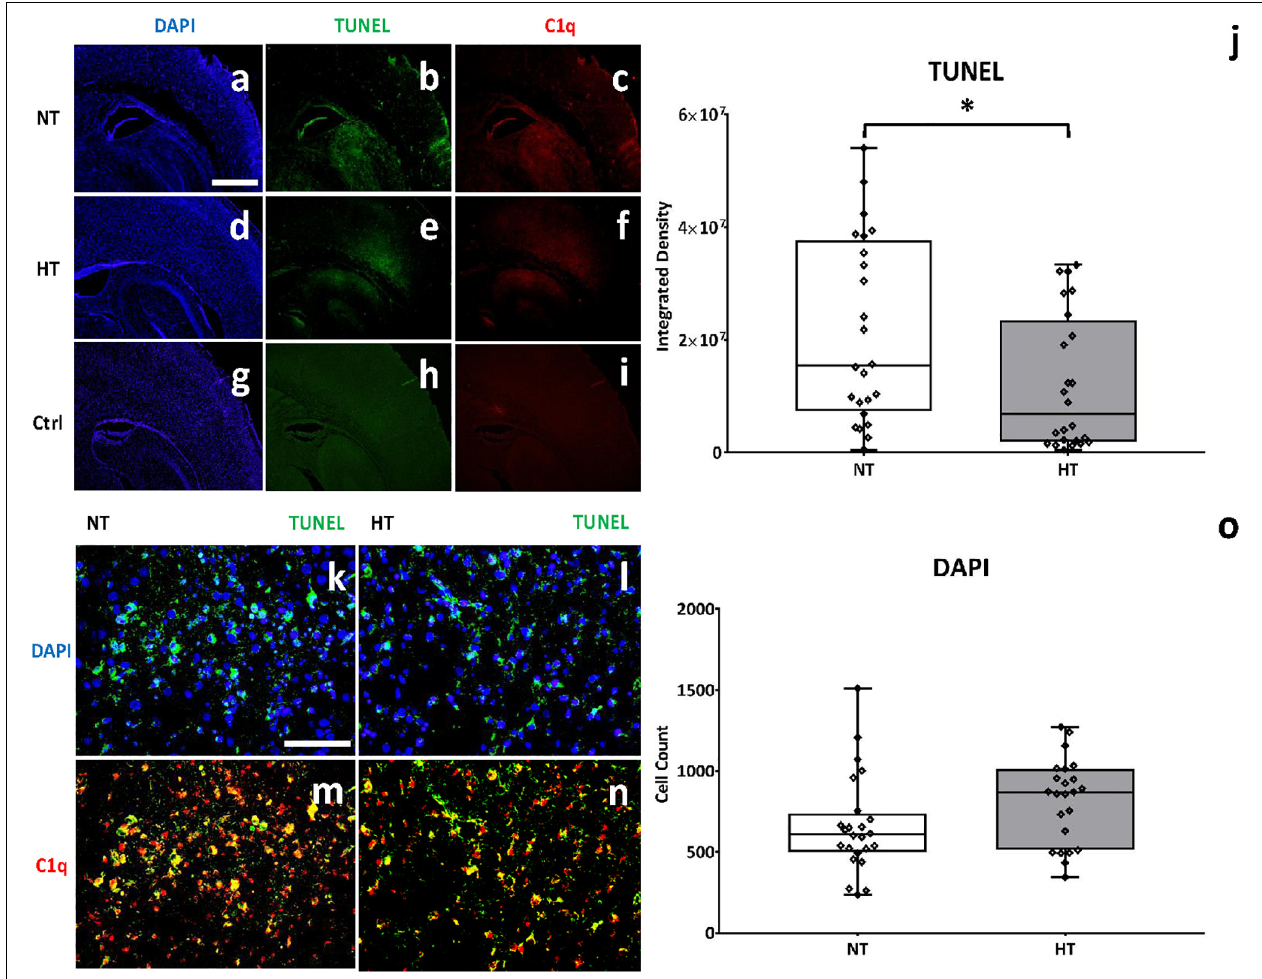
FIGURE 7 | HT treatment may be associated with decreased C1q binding on cells undergoing apoptosis. NT animals (a) showed markedly reduced nuclear density in the cortex as demonstrated by DAPI staining when compared to HT (d) treated and Control/Sham (g) animals. Quantification of stained nuclei demonstrated improved cell counts in HT treated animals when compared to NT (o) . A marked increase in TUNEL positive cells (b) and c1q expression (c) was observed in NT animals, when compared to control animals (h,i) . HT treatment significantly reduced TUNEL positive cells (e) and C1q expression (f) when compared to NT animals. Higher magnification demonstrated decreased DNA fragmentation (green) in nuclei in HT treated animals (l) when compared to NT controls (k) . There was extensive co-localization of C1q in nuclei with DNA fragmentation in NT animals (m) , and a qualitative reduction in C1q/TUNEL co-localization in HT treated animals (n) . [Ipsilateral hemispheres, cortex and hippocampus, 48 h after injury; n = 4 per group, 10 fields per brain, Magnification 4X (a–f) , 40X (g–j) ; 40X fields showing cortex; blue, DAPI; green, TUNEL; red, C1q; NT (white bar), HT (gray bar). Scale bars: 4X images 500 µ m, 40X images 50 µ m; error bars denote ± SD, * denotes P <